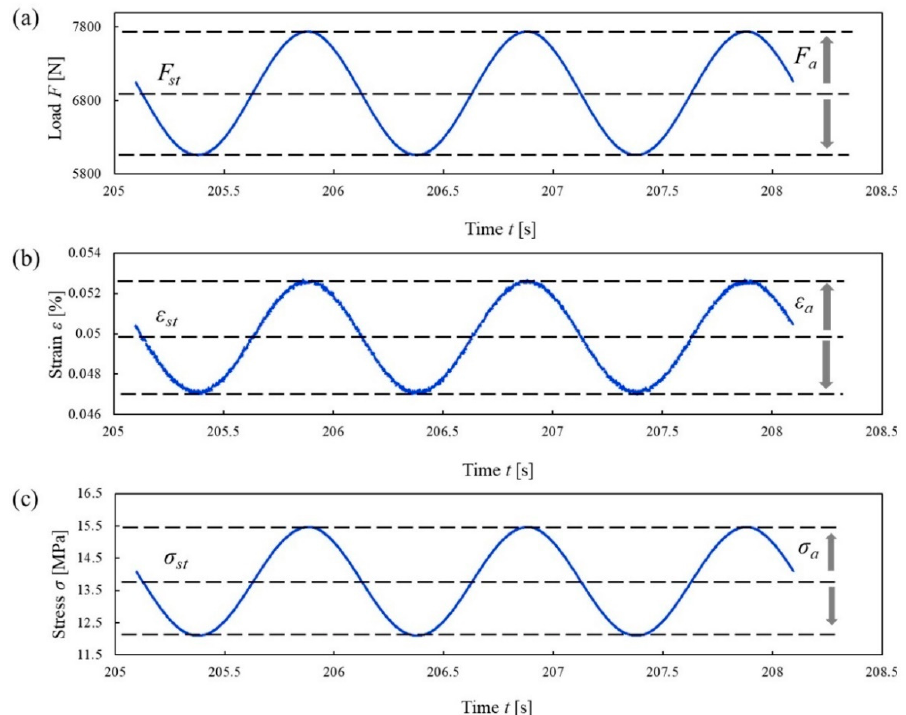
Figure 13. Experimental data obtained during dynamic loading of a sample 2/46 at a frequency f of 1 Hz (cycles 80–82): ( a ) dynamic load F with an average F st and amplitude F a , applied to the sample; ( b ) longitudinal strain ε of the sample; ( c ) stress σ in the sample.